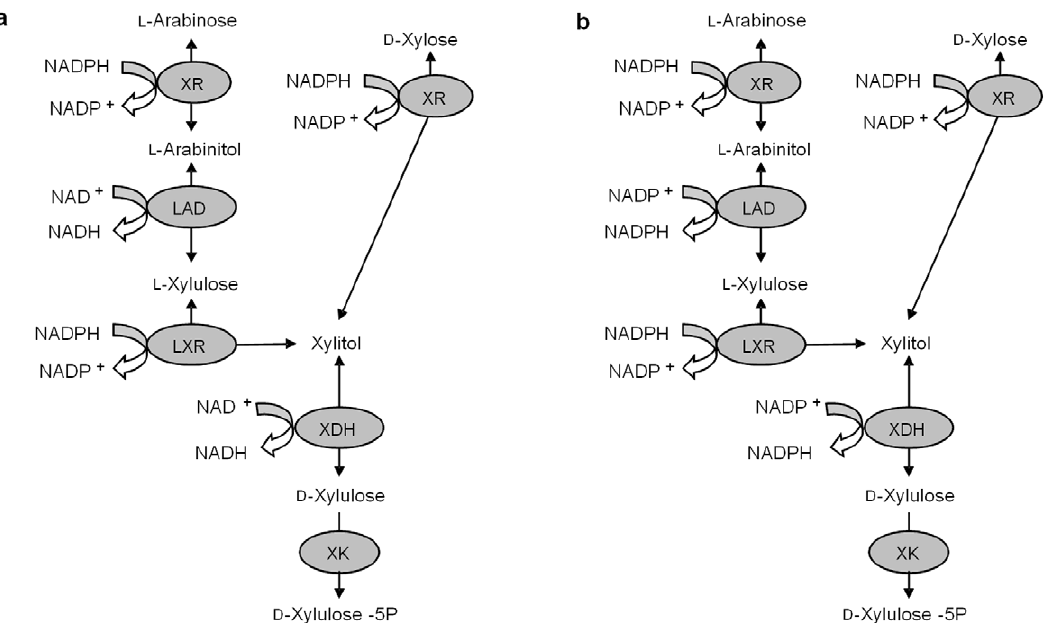
Figure 1. (a) Engineered cofactor imbalanced L-arabinose and D-xylose pathways, (b) Engineered cofactor balanced L-arabinose and D-xylose pathways. XR: Xylose reductase; LAD: L-arabitol dehydrogenase; LXR: L-xylulose reductase; XDH: xylitol dehydrogenase; XK: